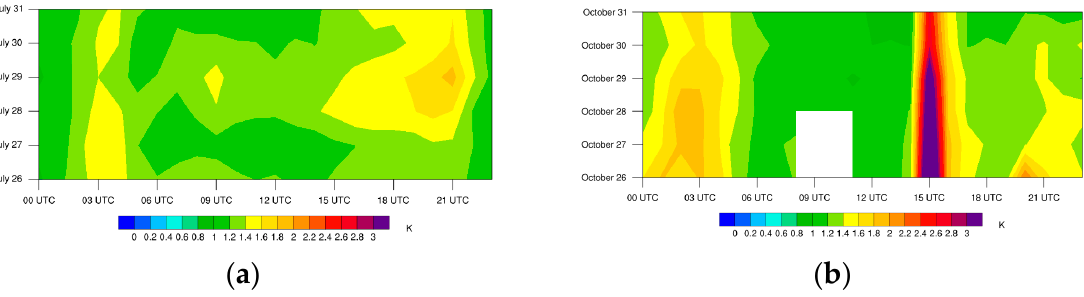
Figure 4. Standard deviation between Fengyun-4B/AGRI 3.75 μ m brightness temperature observation and RTTOV simulation over ocean ( a ) from 26 July to 31 July and ( b ) from 26 October to 31 October 2022 (white color indicates missing data).